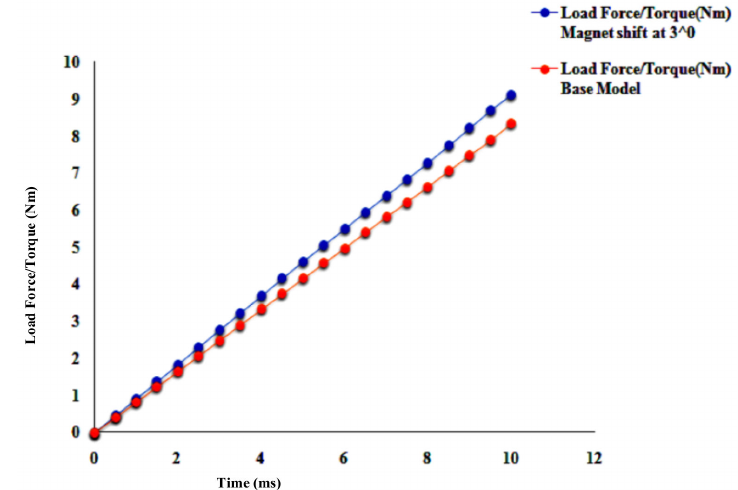
Figure 16. Load force/torque vs. time.